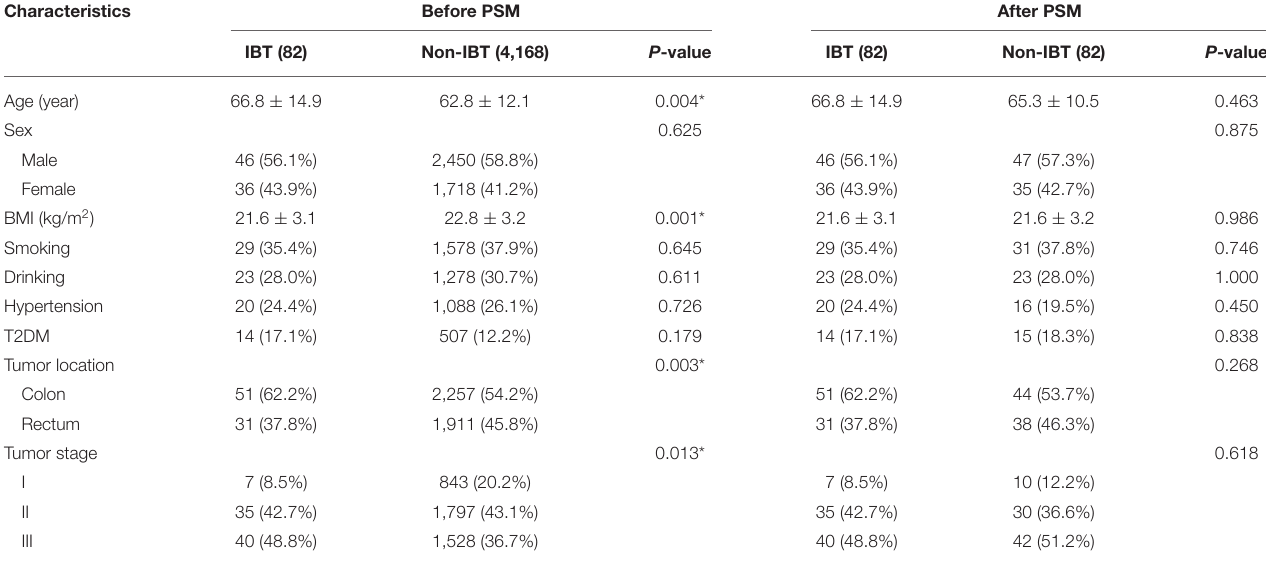
TABLE 5 | Baseline characteristics before and after PSM.